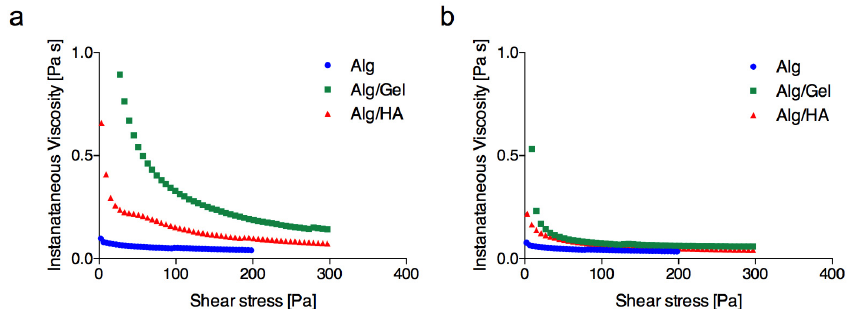
Figure 4. Instantaneous viscosity as a function of shear stress for plain alginate (2% w/v) and alginate blend solutions (Alg/Gel is composed of 2% (w/v) alginate and 1.5% (w/v) gelatin; Alg/HA is composed of 2% (w/v) alginate and 0.2% (w/v) HA) at 25 °C ( a ) and 37 °C ( b ).